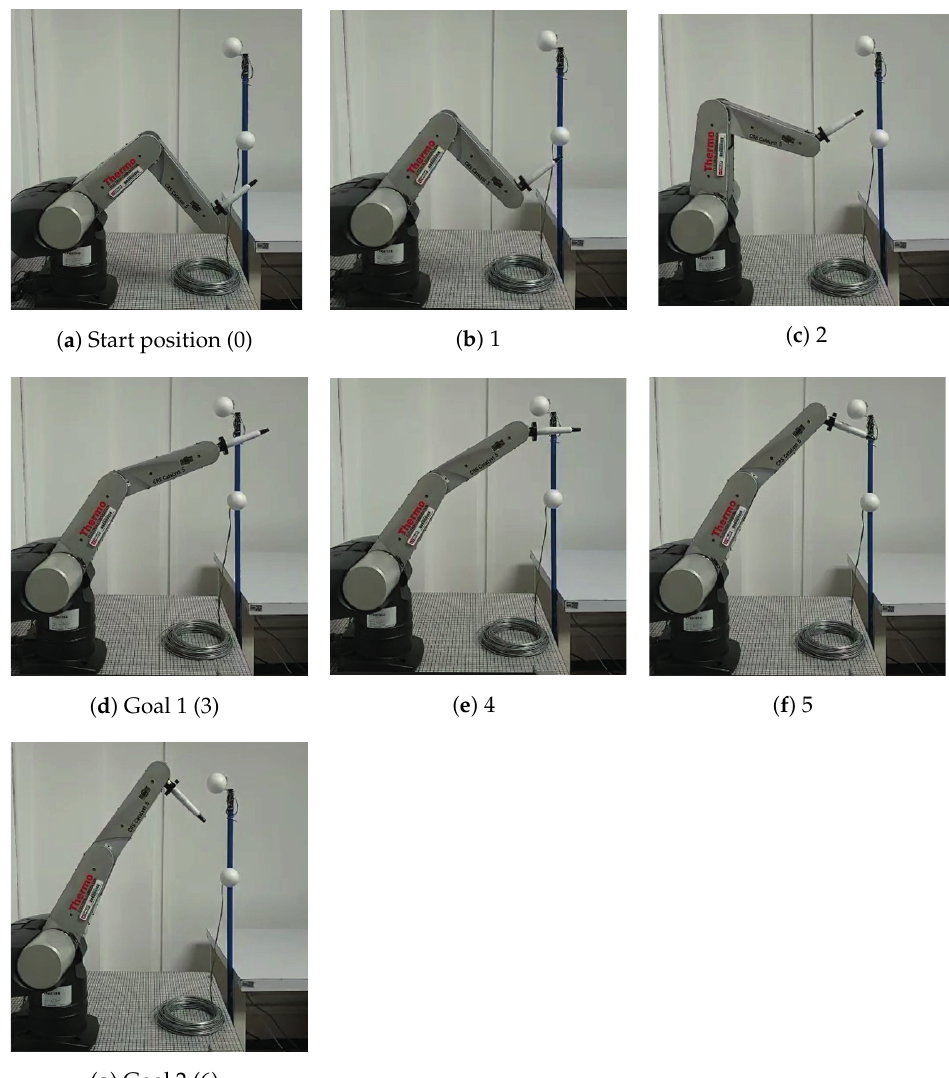
Figure 23. Sequence of images that describe the movement of the CRS CataLyst-5 robot avoiding two